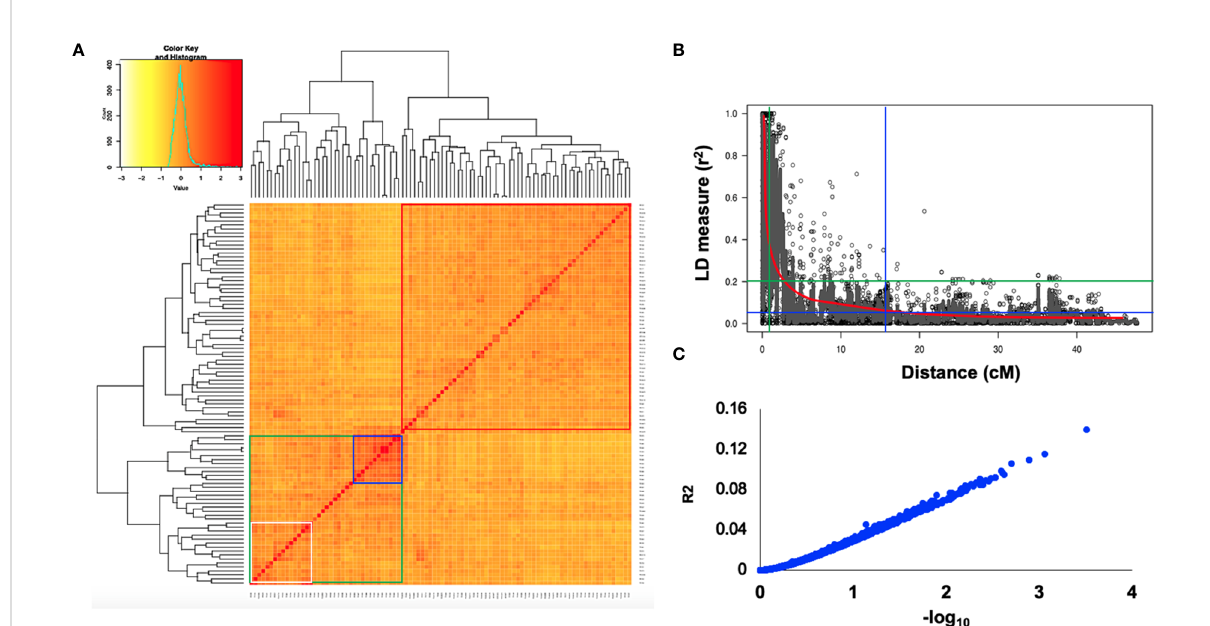
FIGURE 5 (A) Heat map of kinship matrix for the 5063 SNP markers. (B) Plots of LD values (r 2 ) against genetic distance (cM) between pairs of SNPs. The red line indicates the non-linear regression line of the LD decay, the blue line displays the intersection of the 95% percentile representing the background LD, green line shows the intersection of an r 2 value of 0.2 with the regression line (C) R 2 values against – log 10 over all